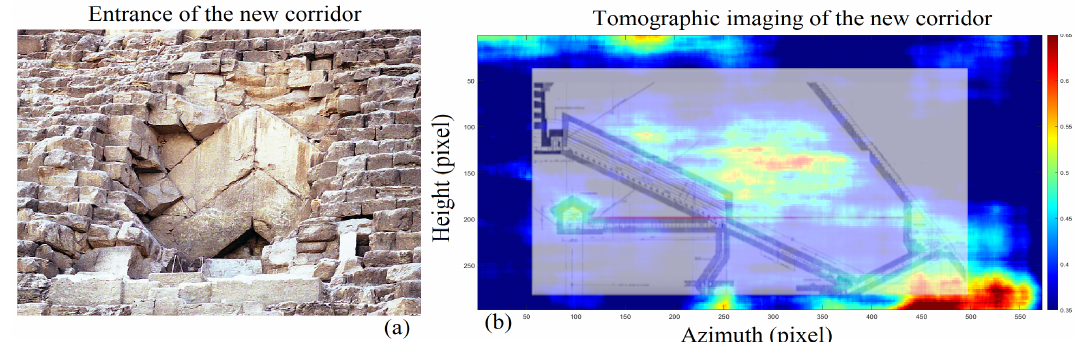
Figure 53. Entrance on Khnum-Khufu. ( a ): Optical image. ( b ): Tomographic map (magnitude).